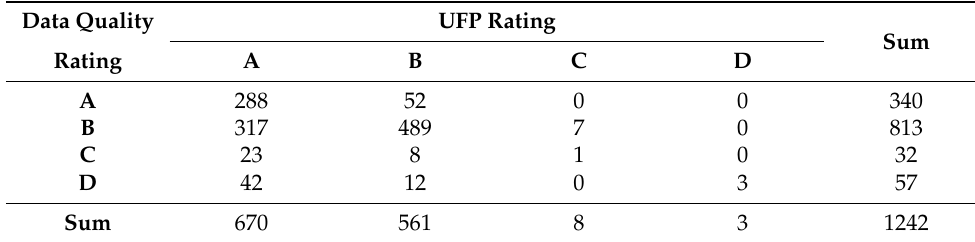
Table 3. Counts for Data Quality Rating and UFP Rating